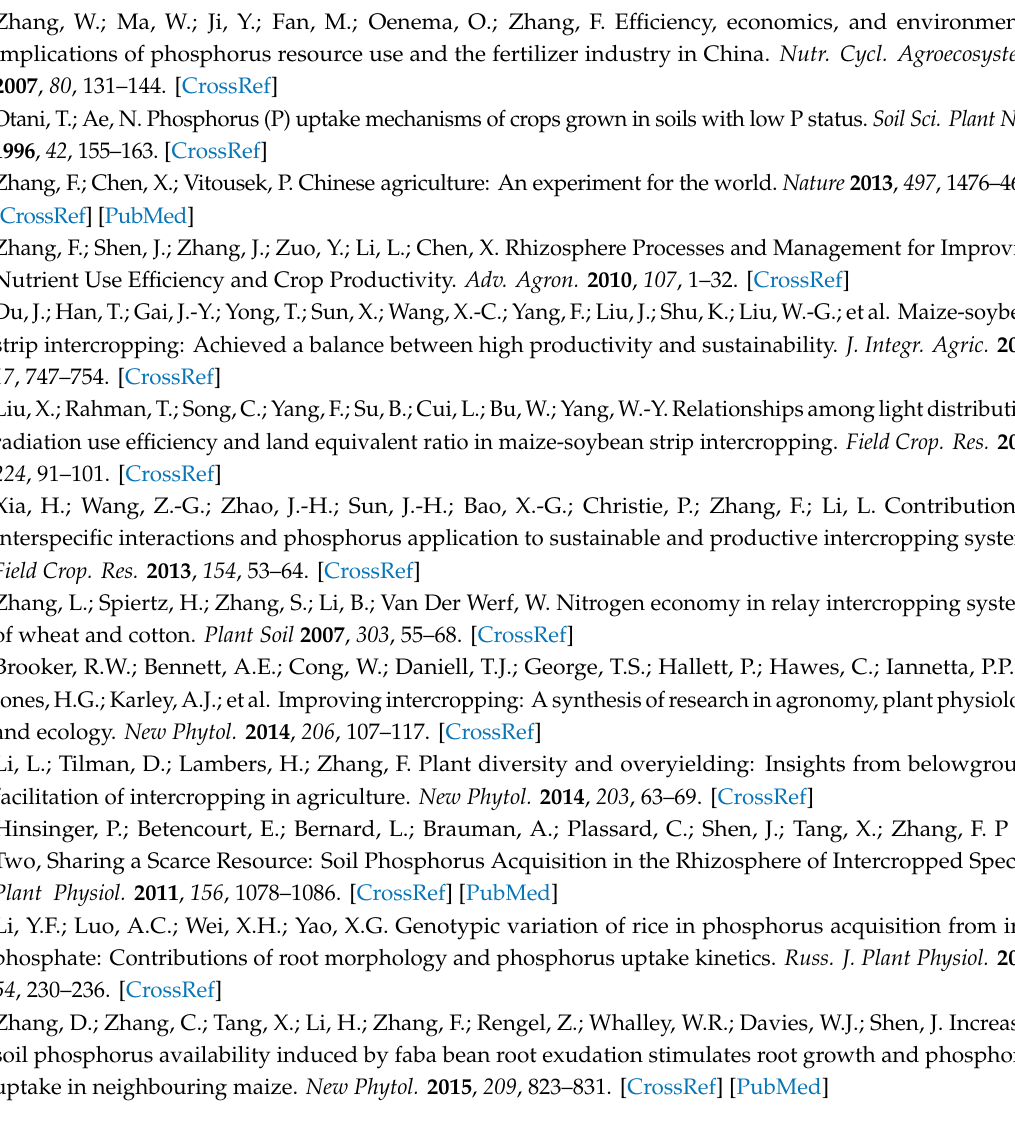
Figure S1: The shoot P accumulation as a ff ected by the P application and light condition in the pot experiment. Figure S2: E ff ect of cropping system on the root morphology and distribution; Table S1: The dry matter and shoot P accumulation (g m − 2 ) of soybeans during the growth period as a ff ected by P application and cropping system in the field